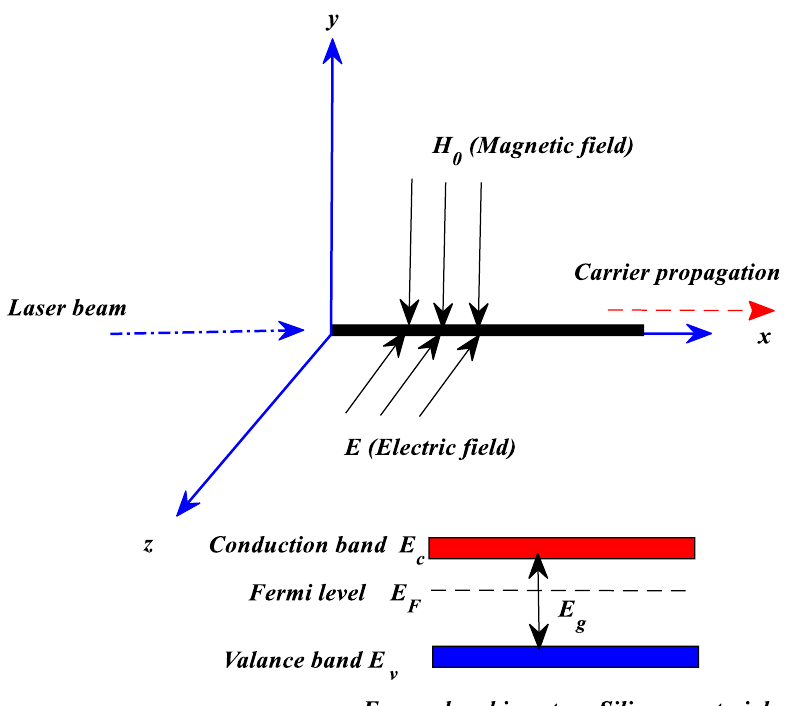
Figure 1. Schematic of the problem.